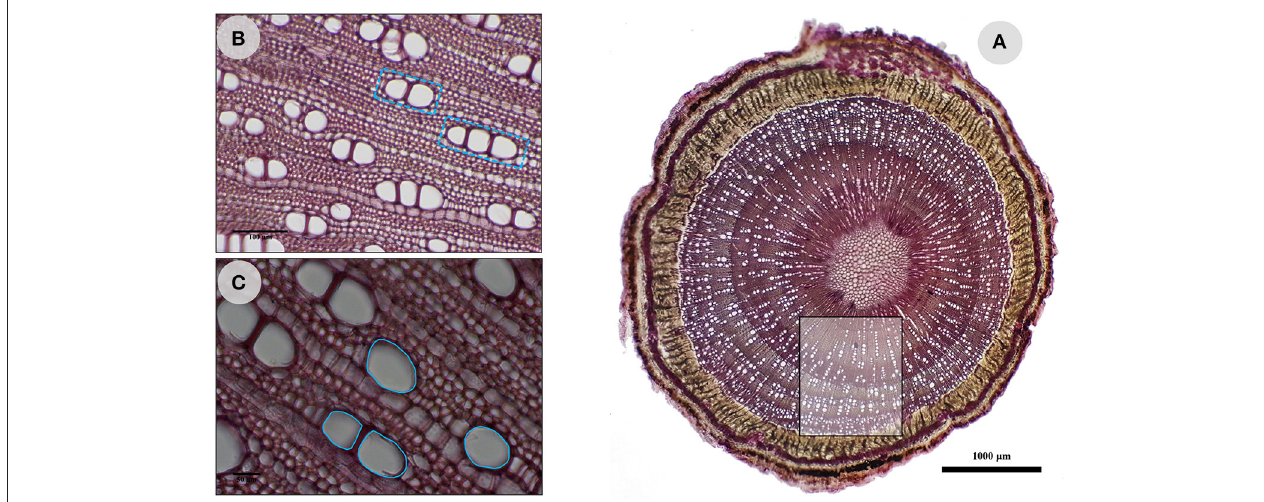
FIGURE 2 | Wood anatomy of O. europaea L. subsp. europaea var. sylvestris and measured anatomical characters. (A) Vessel density (DVS, number of vessels/mm ² ); (B) number of vessels joined in radial files (NVS, N/group of vessels); (C) vessel surface area (SVS, µ m ² ). The scales are 100 and 50 µ m for (B,C) , respectively.